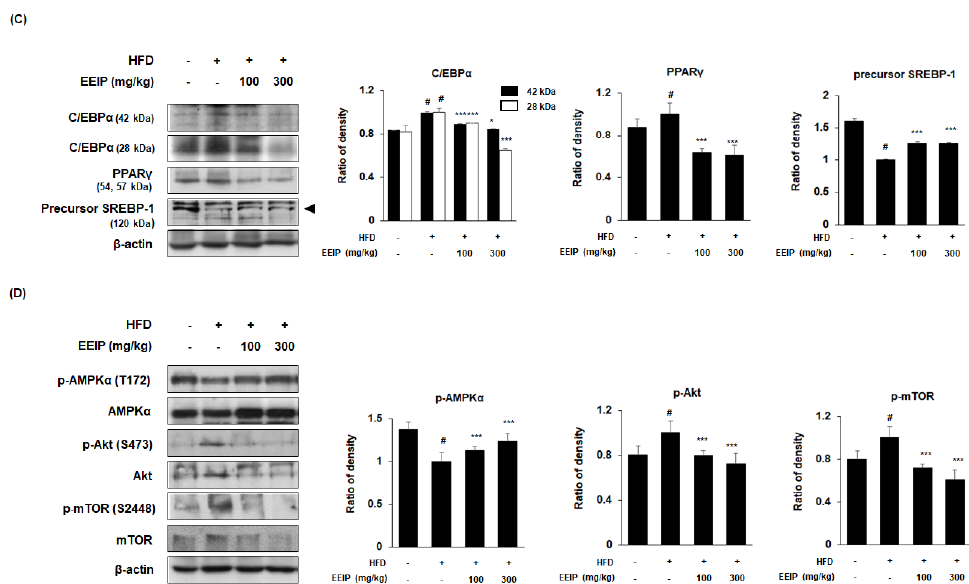
Figure 7. Effect of EEIP on liver fat accumulation in HFD−fed obese mice. ( A ) H&E−stained images from section slides of the liver tissue. ( B ) Assessment of liver weight. ( C , D ) Adipogenic−related protein expression of the liver tissue was determined by Western blotting analysis and β-actin was used as the internal control. Densitometric analysis was performed using Bio−Rad Quantity One Software (BioRad; Hercules, California, USA). Values are represented as the mean ± SEM. # p < 0.05 vs. normal diet control group; * p < 0.05, ** p < 0.01, and *** p < 0.001 vs. HFD group.